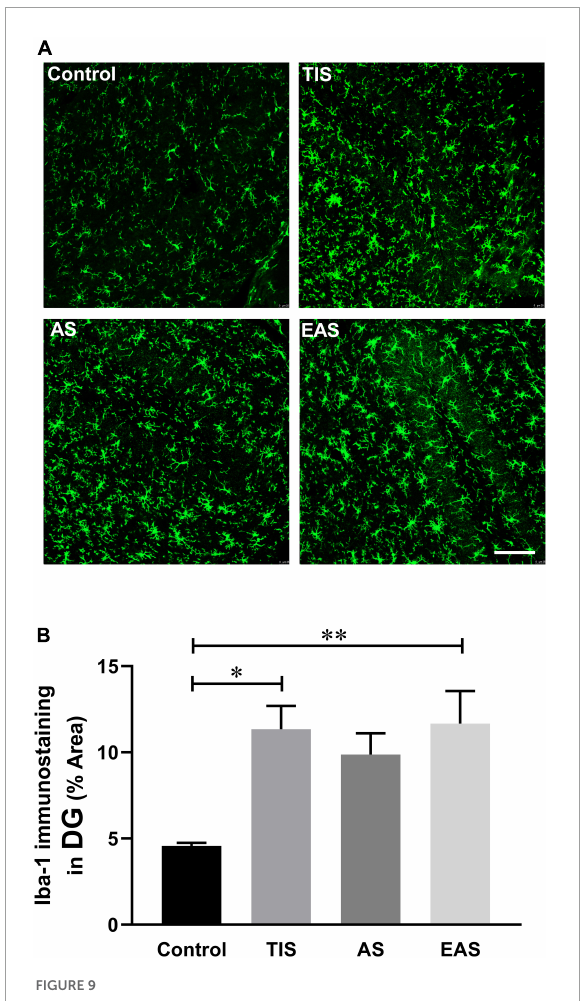
FIGURE9 Hippocampal microglial activation on postoperative day 1. (A) Representative image staining in the hippocampal DG region. Scale bar: 50 µ m. (B) Microglia in the hippocampal dentate gyrus region were significantly activated after TIS and EAS. No significant differences were found between the three surgical groups. Data represent mean ± SEM ( n = 6). ∗ P < 0.05; ∗∗ P <